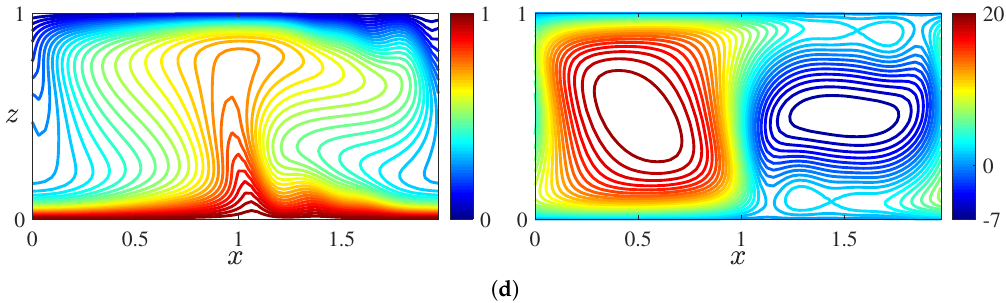
Figure 6. Isotherms (left) and streamlines (right) of steady convective states at Ra = 500 and L = 2. ( a ) φ = 0 ◦ ; ( b ) φ = 10 ◦ ; ( c ) φ = 20 ◦ ; ( d ) φ = 30 ◦ . As the inclination angle is increased, the natural roll (positive ψ ) becomes more vigorous (see the colorbar limits) and more tightly attached to the walls, while the antinatural roll (negative ψ ) is suppressed and becomes detached from the walls. At φ = 30 ◦ , the antinatural roll makes contact with the upper and lower walls only at certain localized intervals in x .